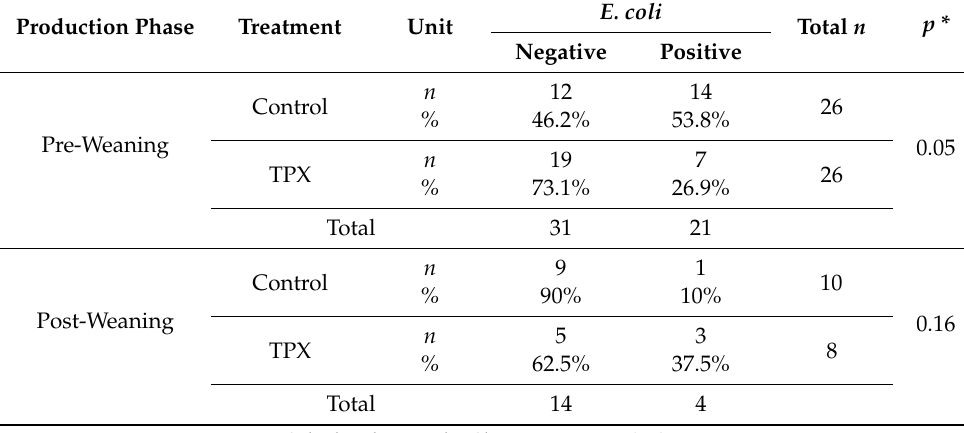
the TPX and Control groups.